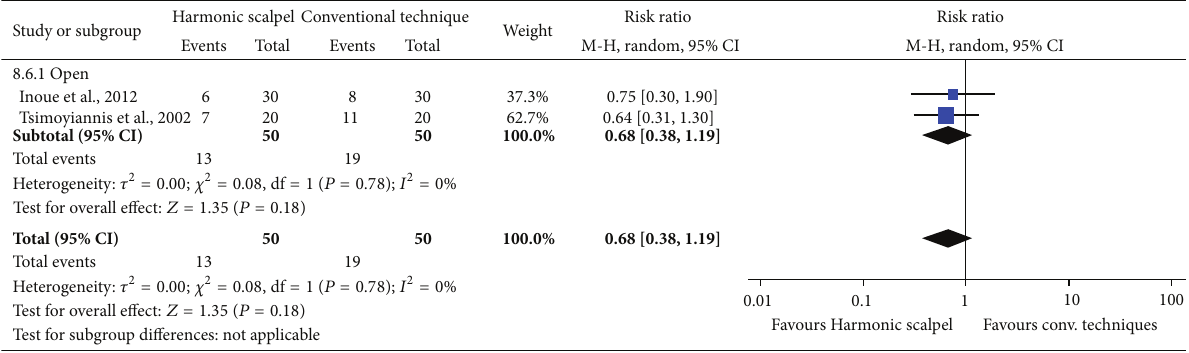
Figure 7: Forest plot of meta-analysis results for patient transfusion risk.